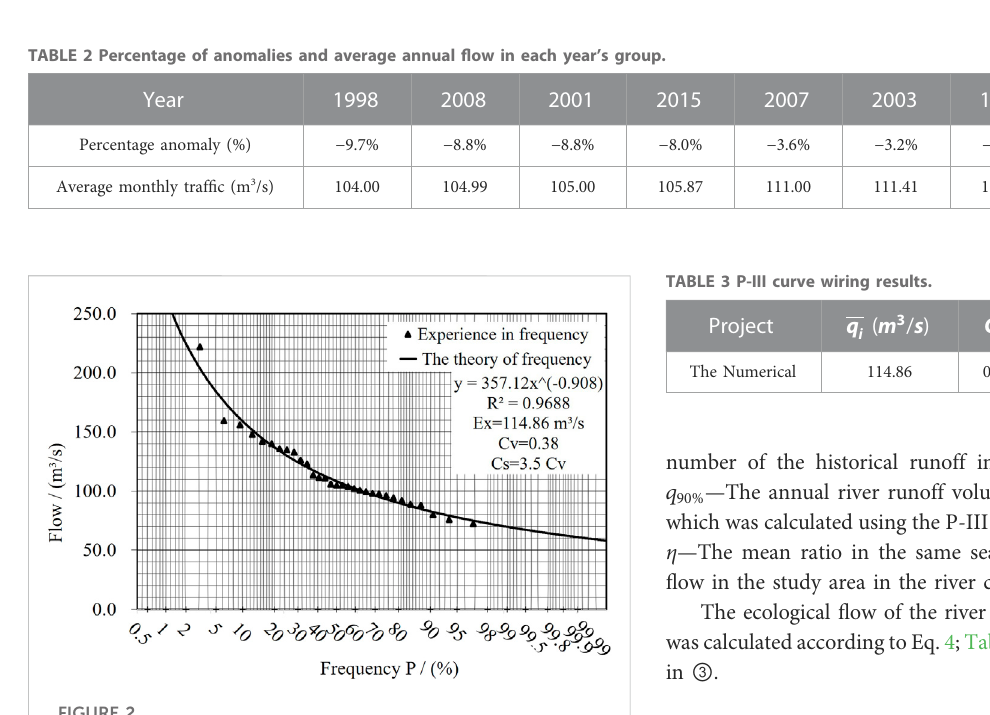
FIGURE 2 Historical fl ow-frequency curve of Wudu Hydrological Station.